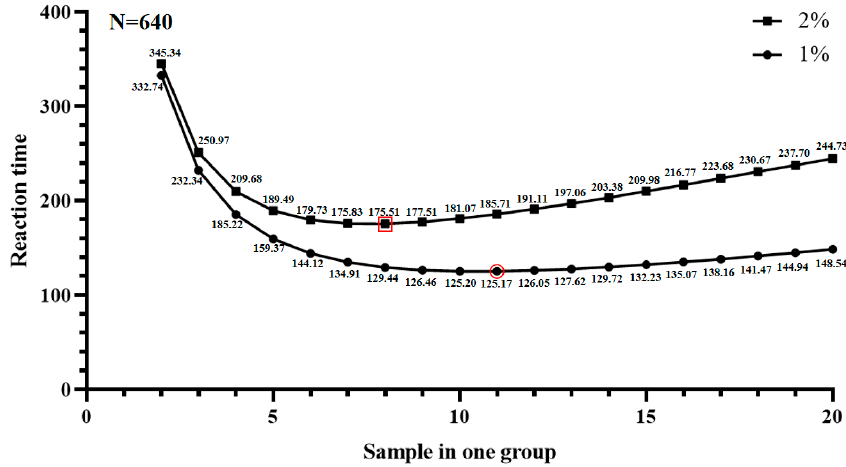
Figure 7. The reaction times of different sizes of one mixed group. The least reaction time will be obtained when the estimated mutation frequencies are 1% and 2%, and the sample sizes in one group are 11 and 8, respectively.